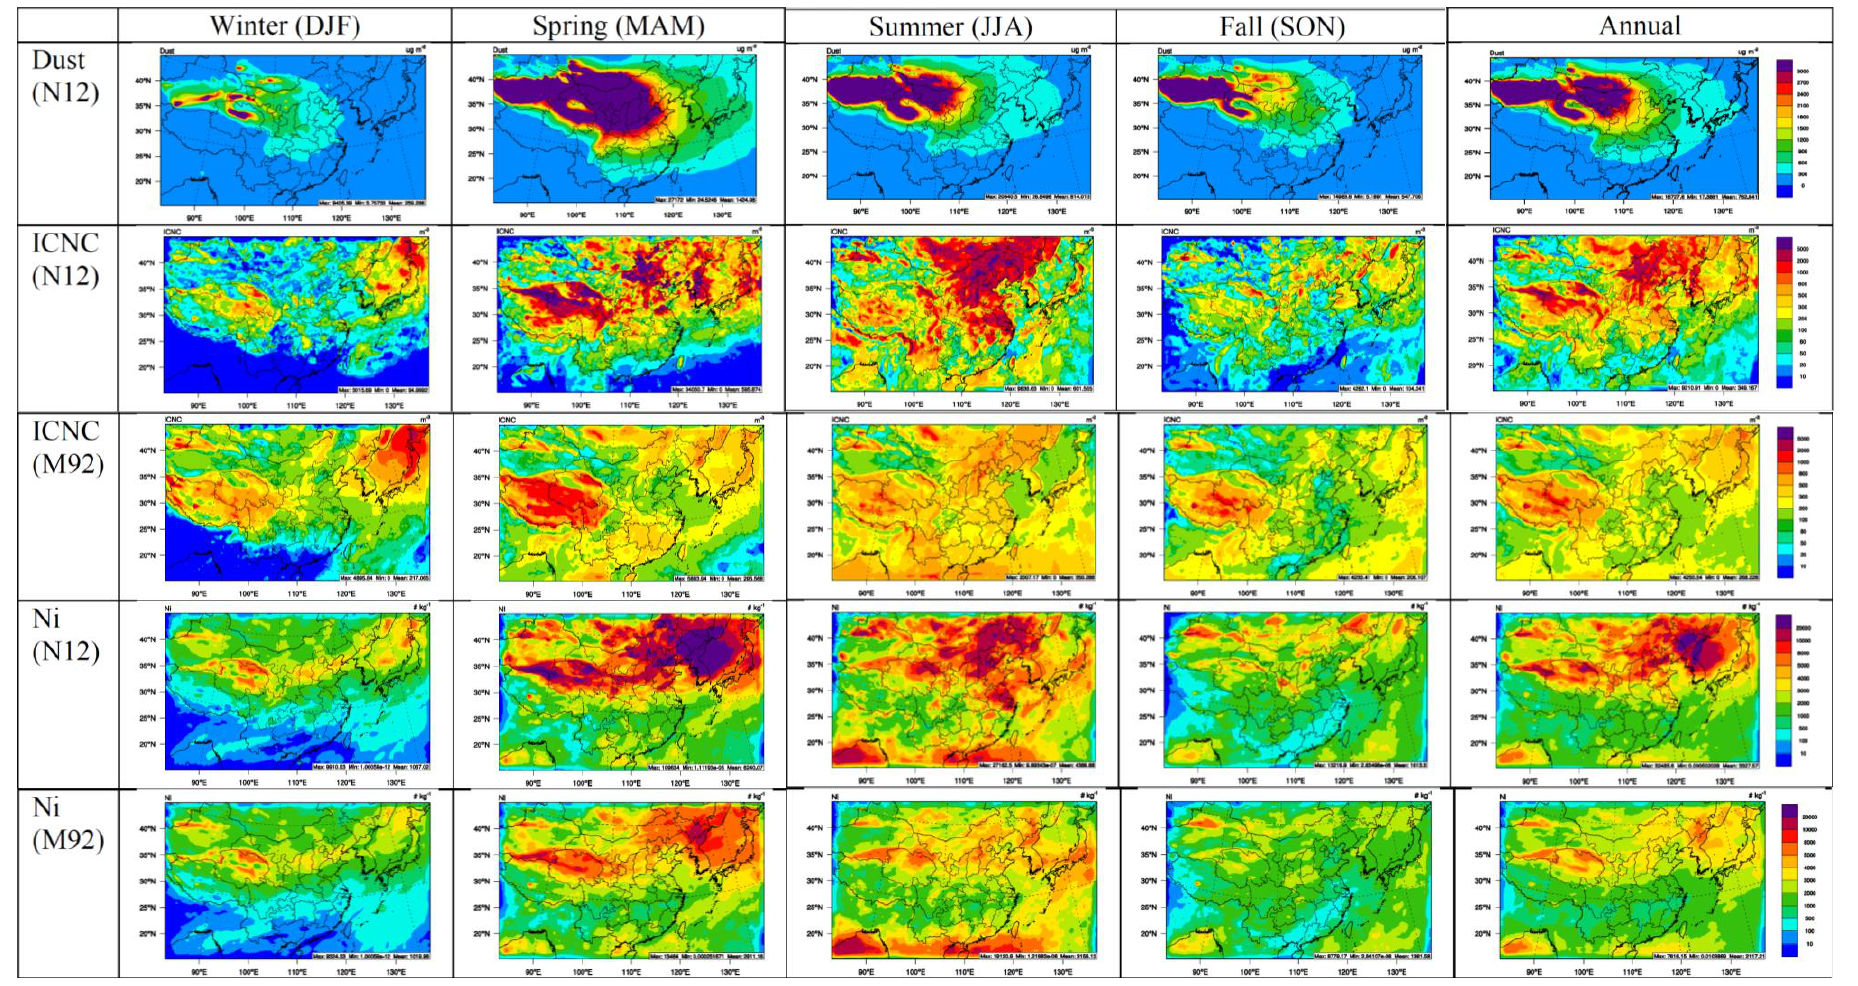
Figure 1. Spatial distributions of total dust concentrations over all model layers from the 2006 simulation with N12 (row 1) and spatial distributions of average values of ICNC and N i over all model layers between simulations in 2006 with N12 and M92 (rows